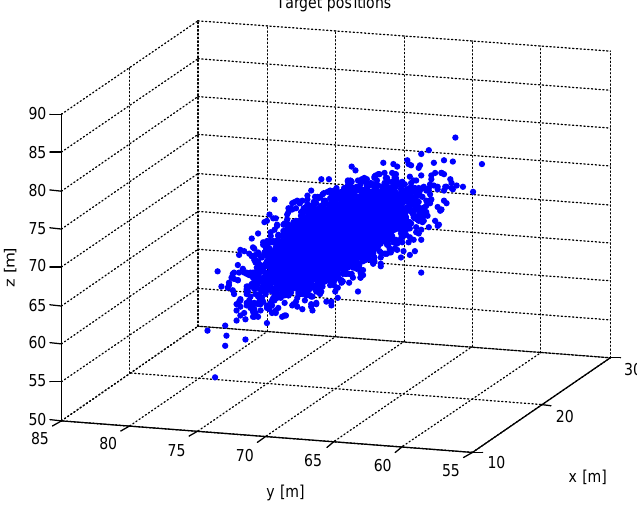
Figure 2. The measured target positions.